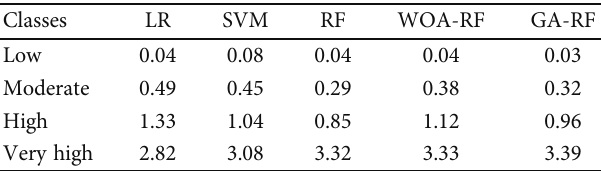
Figure 8: Raster distributions of landslides of di ff erent classi fi cation: (a) LR; (b) SVM; (c) RF; (d) WOA-RF; (e) GA-RF. Table 8: Landslide densities in each zone of landslide